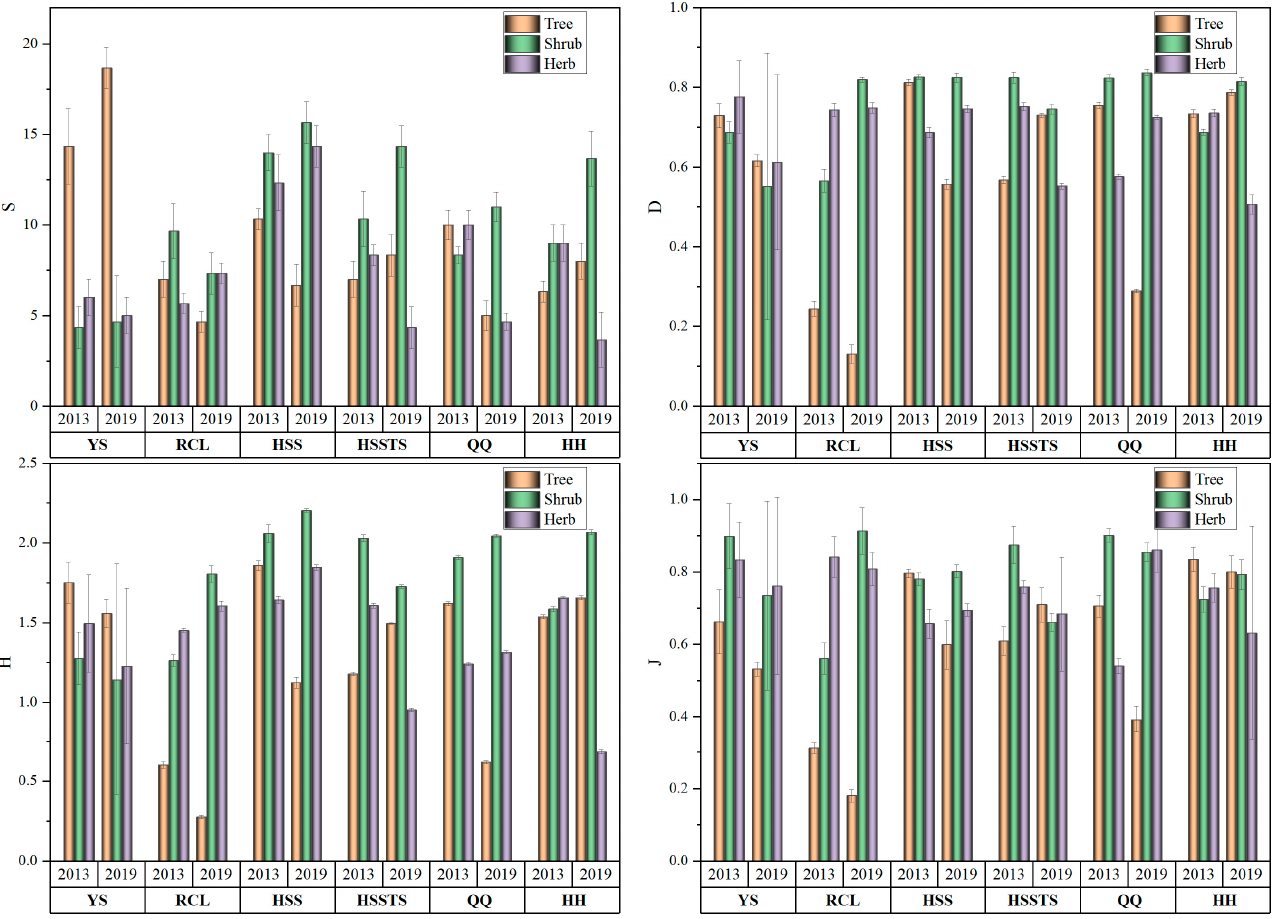
Figure 2. Diversity indices of different forest communities and different forest layers in both 2013 and 2019; (S) Richness index, (D) Simpson index, (H) Shannon–Wiener index and (J) Pielou index.